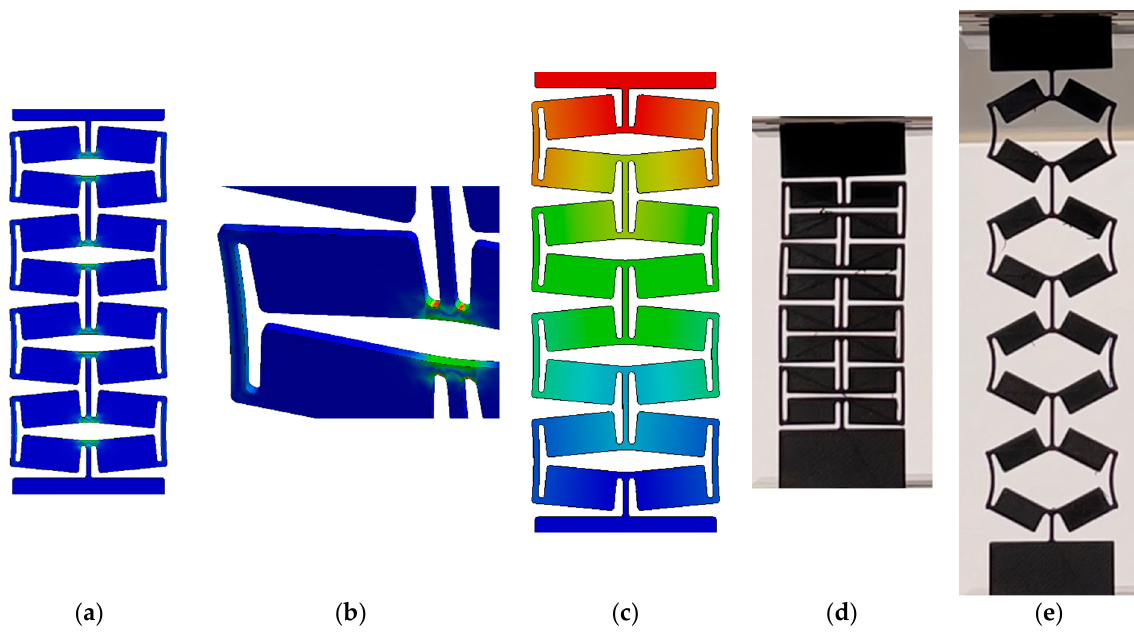
Figure 9. KHS structure with FEA, unstretched length, and stretched length: ( a ) FEA stress analysis, ( b ) FEA close-up for stress concentration, ( c ) FEA displacement, ( d ) printed structure, ( e ) stretched printed structure.